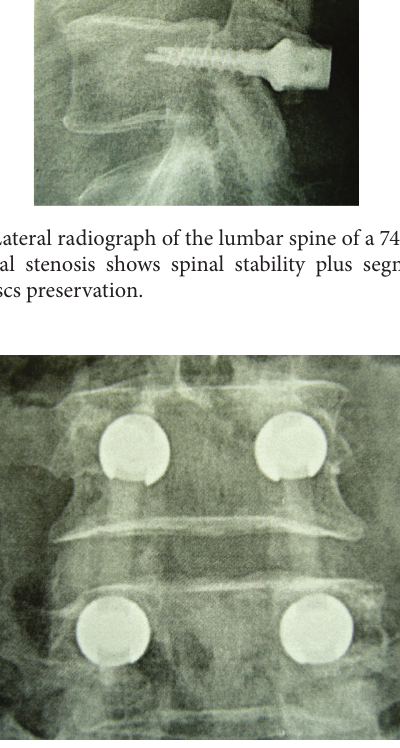
Figure 3: AP view of the same patient. The good radio lucency of PEEK rods enhances postoperative assessment.